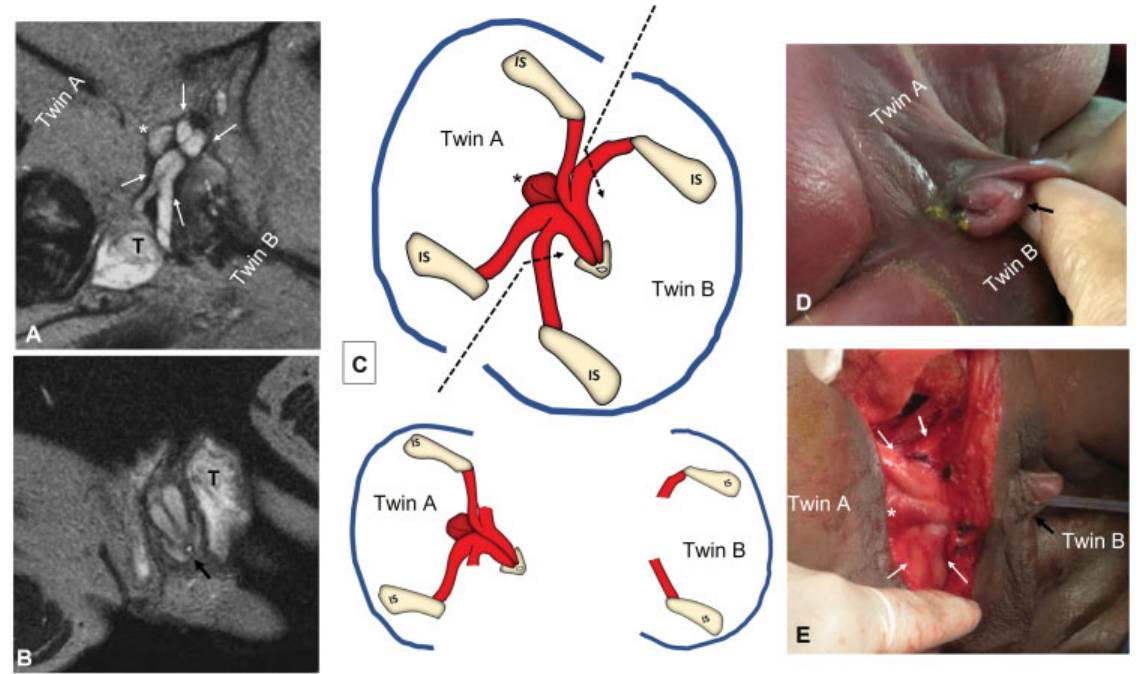
Fig. 6 Demonstration of the peculiar con fi guration of the common central phallus with four crura. ( A, B ) Ultra-thin sections axial MRI (T2 – WI) demonstrating the erectile tissue that appear hyperintense (white) in T2 – WI: asterisk ( (cid:3) ) is marking the location of the bulb of the corpus spongiosum toward twin A; white arrows are pointing to the abnormal four crura of the single phallus (black arrow ). ( C ) Schematic diagram for the plan of separation by dividing crural attachments to twin B; while twin A was selected to keep the common phallus as the bulb of the corpus spongiosum ( (cid:3) ) was naturally located in histerritory.( D ) The common phallus (black arrow) wasassociated withan open urethral plate (proved to be proximal epispadias) with a single perineal ori fi ce discharging both urine and stool. ( E ) Operative fi ndings were well consistent with the preoperative imaging and schematic drawings demonstrating the bulb of the corpus spongiosum ( (cid:3) ) and the abnormal four crura (white arrows) of the single phallus (black arrow). MRI, magnetic resonance imaging; T, testis; WI, weighted